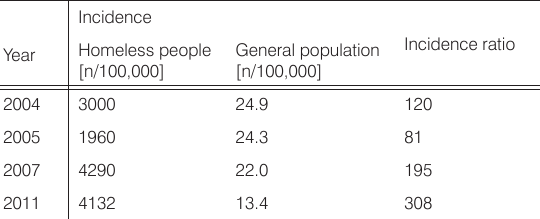
Table 1. The incidence of tuberculosis in the homeless population and in the general population (Warmia and Mazury Region,